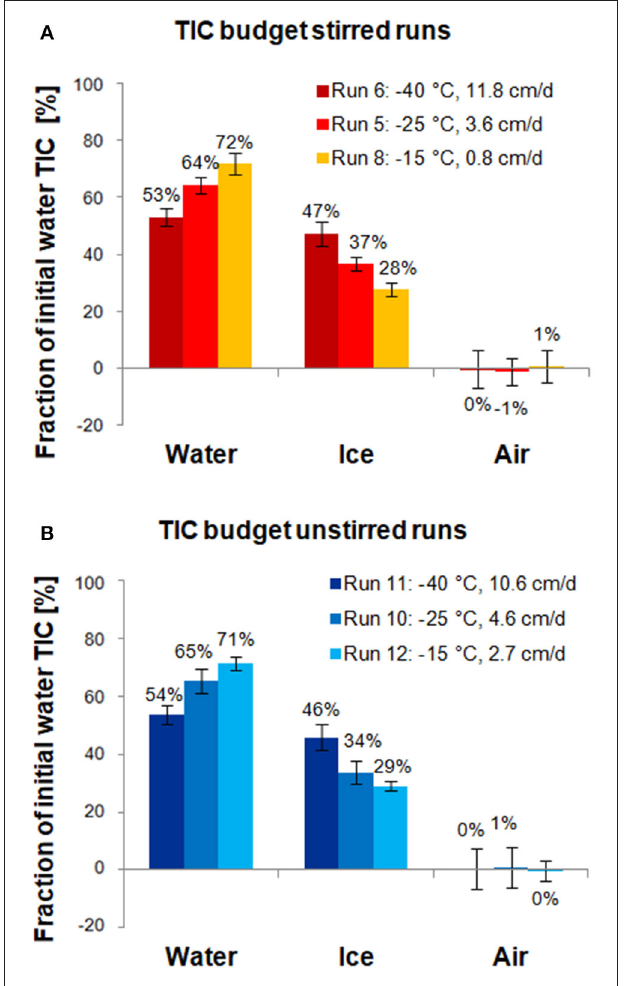
FIGURE 6 | Carbon budgets for stirred runs (A) and unstirred runs (B) . Bars show how much of the TIC initially in the water ultimately converted into ice ends up in the final under-ice water, ice, and air, respectively (Section Carbon Budget). Error bars were computed from uncertainties in water and ice TIC, initial water mass, and ice mass (propagated from salinity measurements).